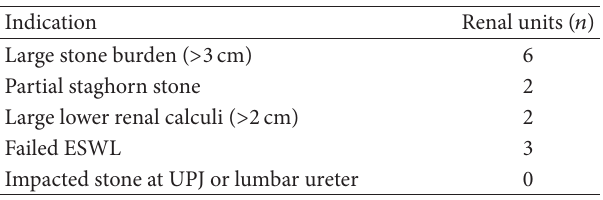
Table 1: Patient demographics and present symptoms. Table 2: Indications for